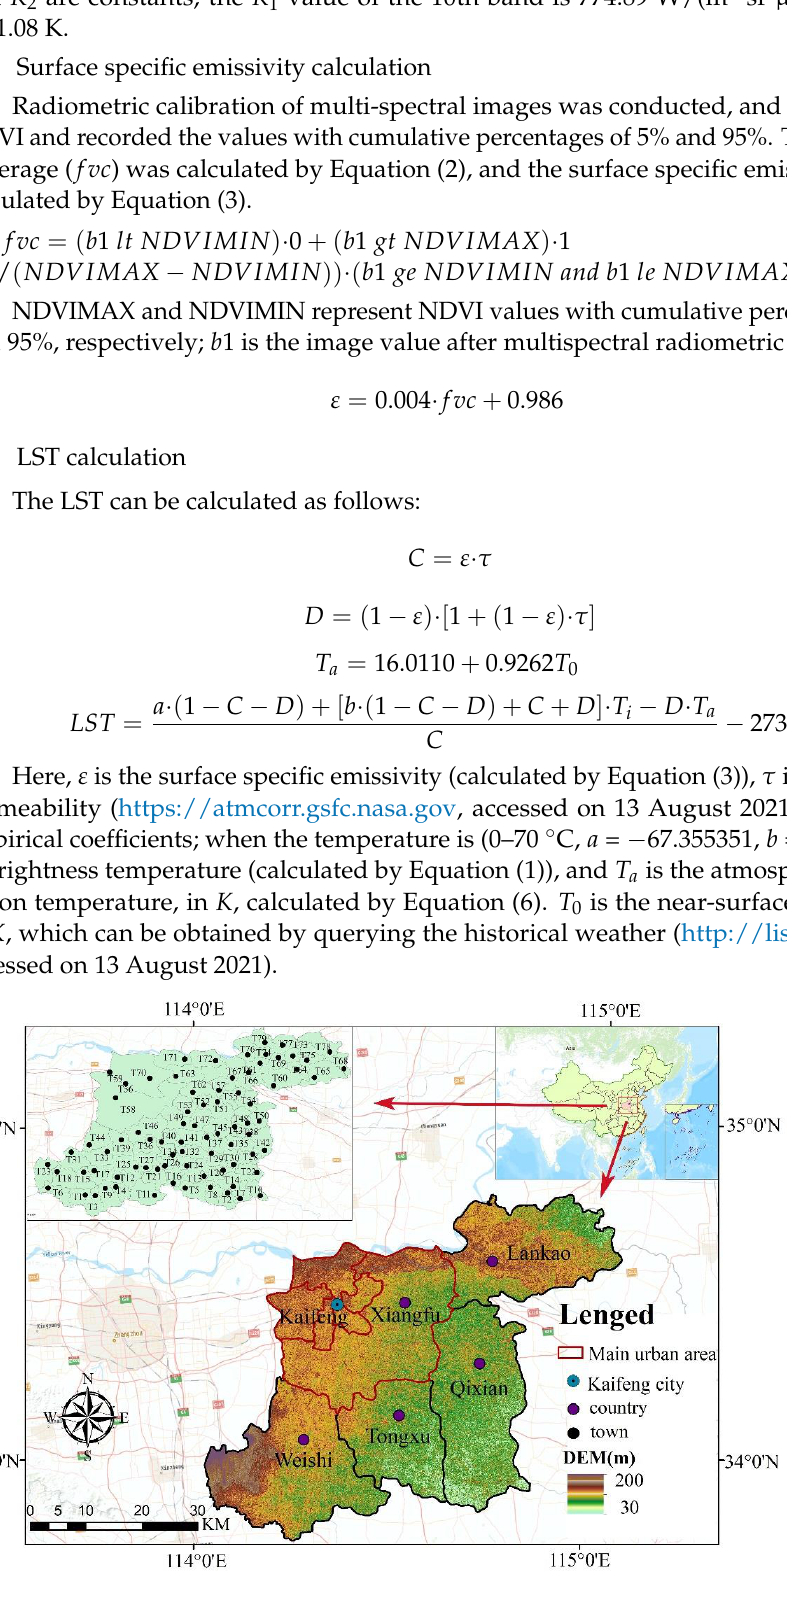
Figure 1. The location of Kaifeng.